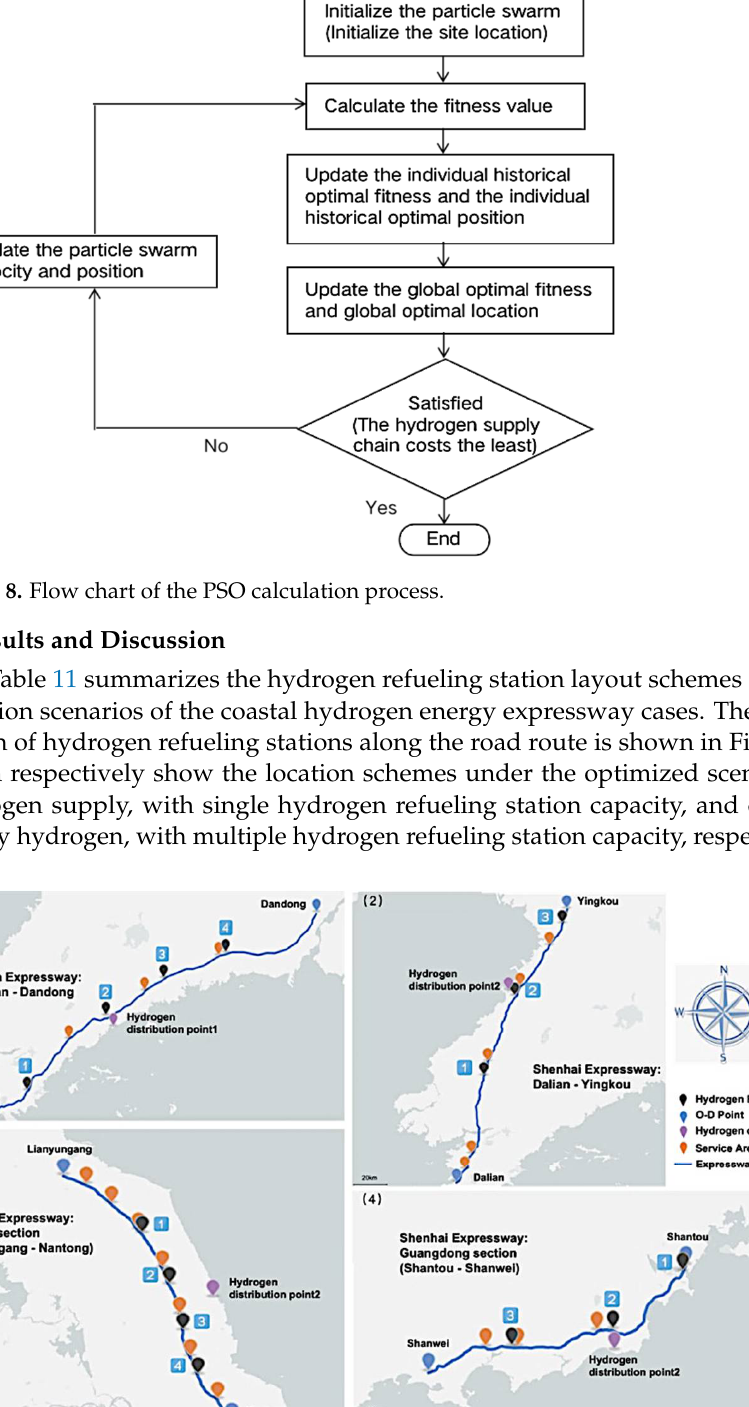
Figure 9. Location optimization result of Scenario 1. (Note: This map is made based on the standard MAP GS(2021)6375 of AmAP, and the base map is not modified). ( 1 ) Location optimization result of Scenario1 in Dalian-Dandong section. ( 2 ) Location optimization result of Scenario1 in Dalian-Yingkou section. ( 3 ) Location optimization result of Scenario1 in Jiangsu section. ( 4 ) Location optimization result of Scenario1 in Guangdong section.